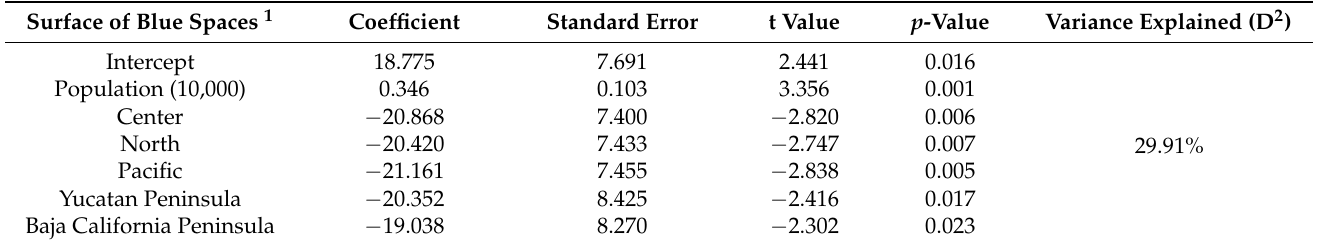
Table 3. Results from the model for the surface of blue spaces, the city population, and the hydro- logical region where they are located.